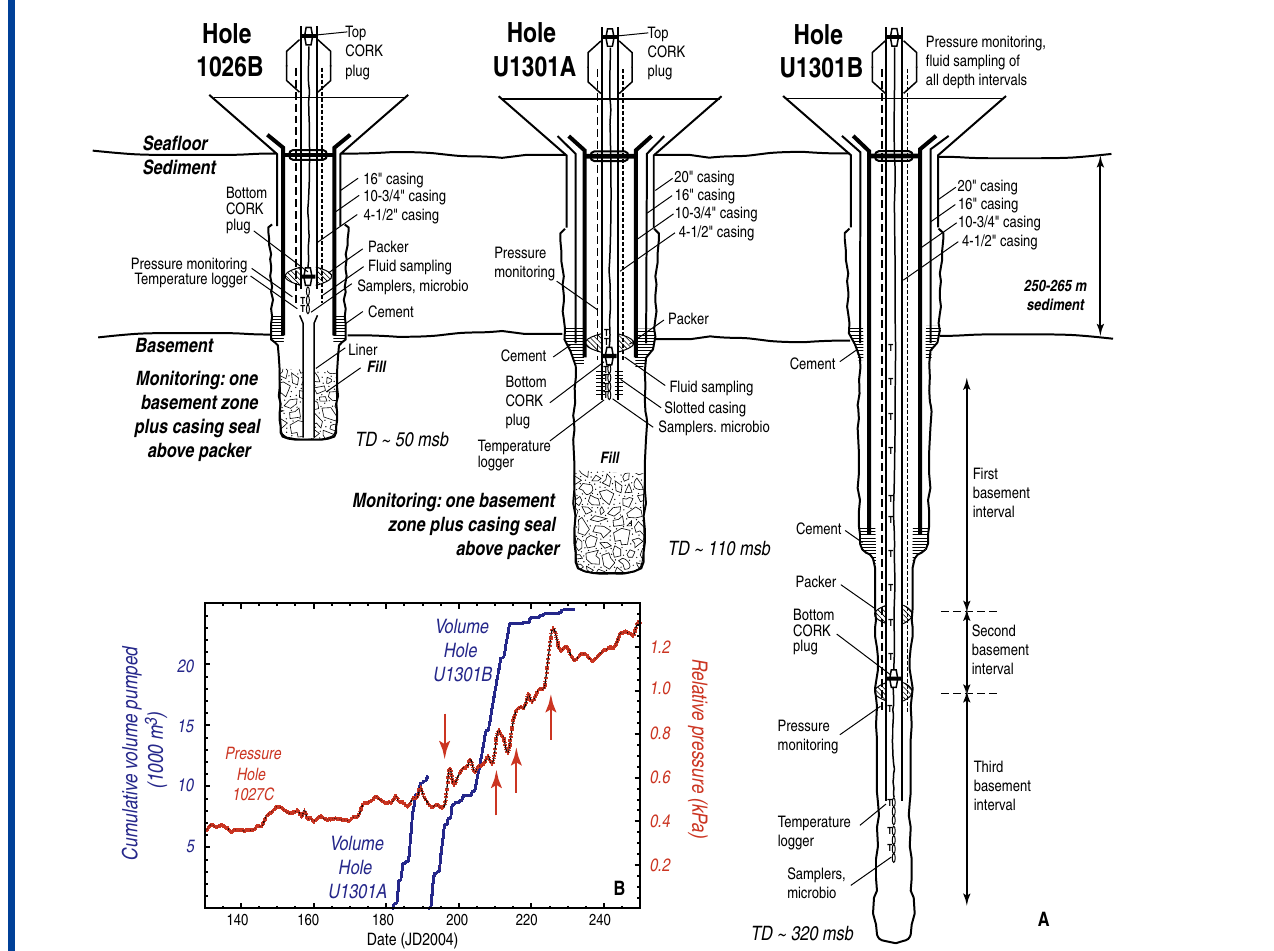
Figure 2. (A) Schematics of casing and CORK system deployed during IODP Expedition 301, not drawn to scale (Fisher et al., 2005b). Primary CORK casing is 4-1/2" in diameter and is sealed with two plugs, one at depth and one at the top. Additional seals are provided by casing packers, cement at the base of the 16" and 10-3/4" casing strings, and around CORK head inside 10-3/4" casing. CORK systems include up to nine fluid, microbiological, and pressure sampling lines, with ports and screens in one or more basement or cased depth intervals, and a variety of fluid and microbiological sampling